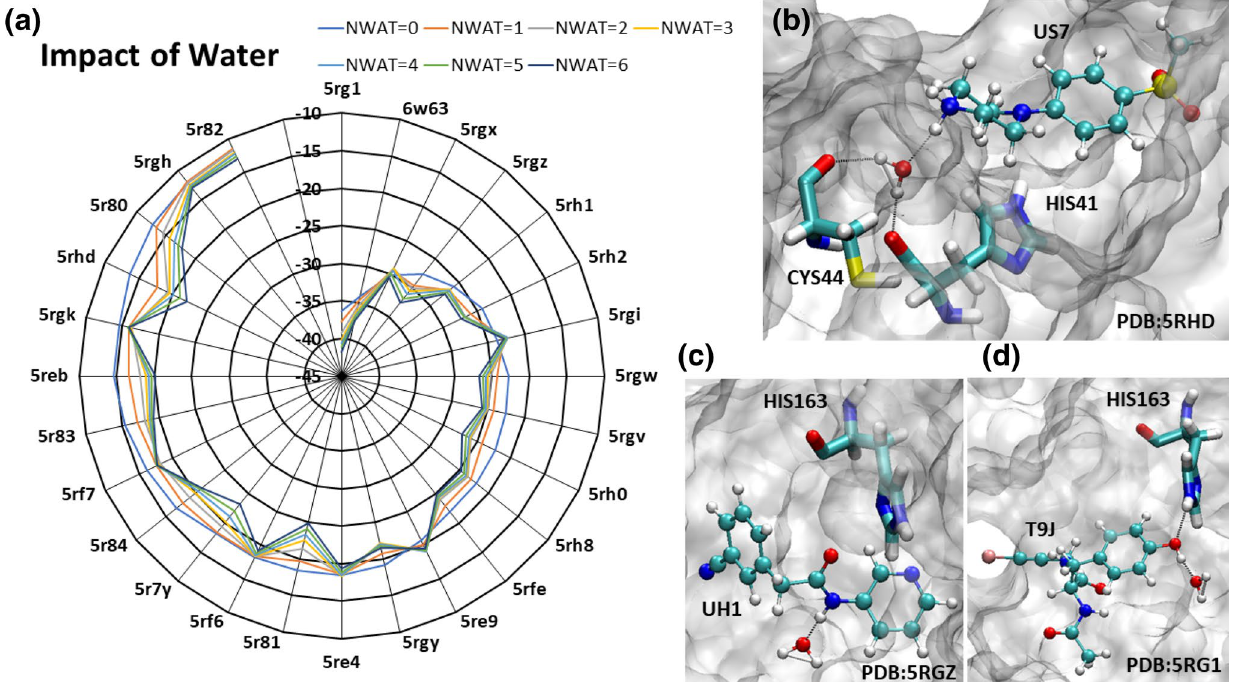
Figure 9. A polar plot describing the change in binding affinity scores of the select ligand–M pro complexes in response to the presence of varying numbers of explicit water molecules (NWAT = 0–6) ( a ), and the 3D snapshots describing the different water interactions with the ligand ( b – d ) are also shown. In the 5RHD complex, a water molecule bridged the protein and the ligand acting as a proton donor to M pro and proton acceptor for the ligand ( b ). In PDBs 5RGZ and 5RG1, a key water molecule interacted with the carboxamide and hydroxyl side chains of the ligand that helped to maintain the association of the ligands with the lateral pocket ( c , d ) in M pro . The molecular graphics in the figure were generated using VMD 1.9.3 63 ( b – d ) while the radial plot in ( a ) was generated using Microsoft Excel 365 (https:// www. office.